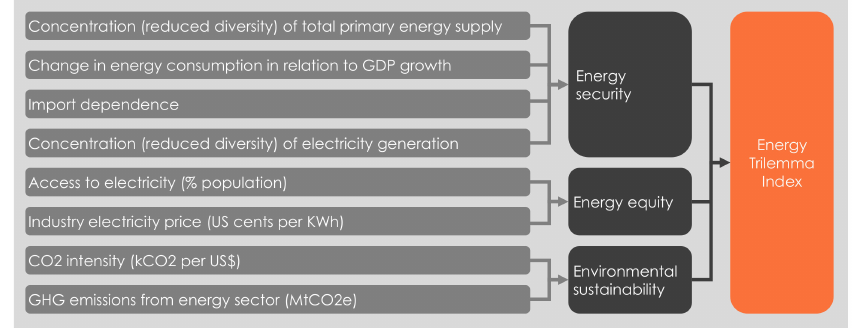
Figure 3. Structure of the indicators of the pathway calculator of the WEC (World Energy Council). Source: Created by authors using data from